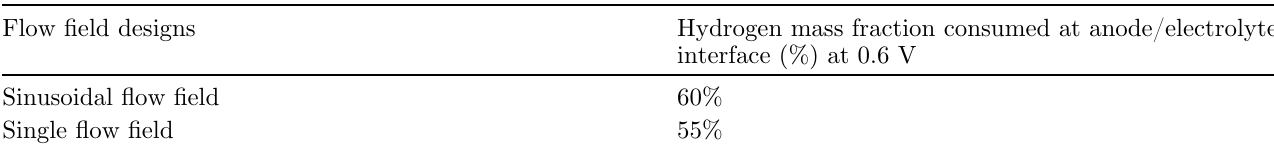
Table 5. Maximum value consumed of hydrogen mass fraction at the anode/ electrolyte interface.